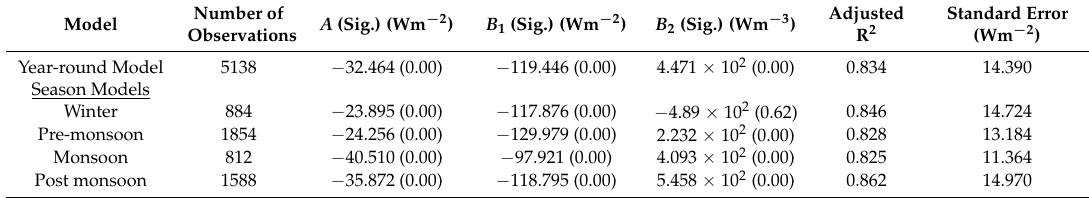
Table 2. Regression results of year-round and seasonal models to predict atmospheric aerosol (ADRF).